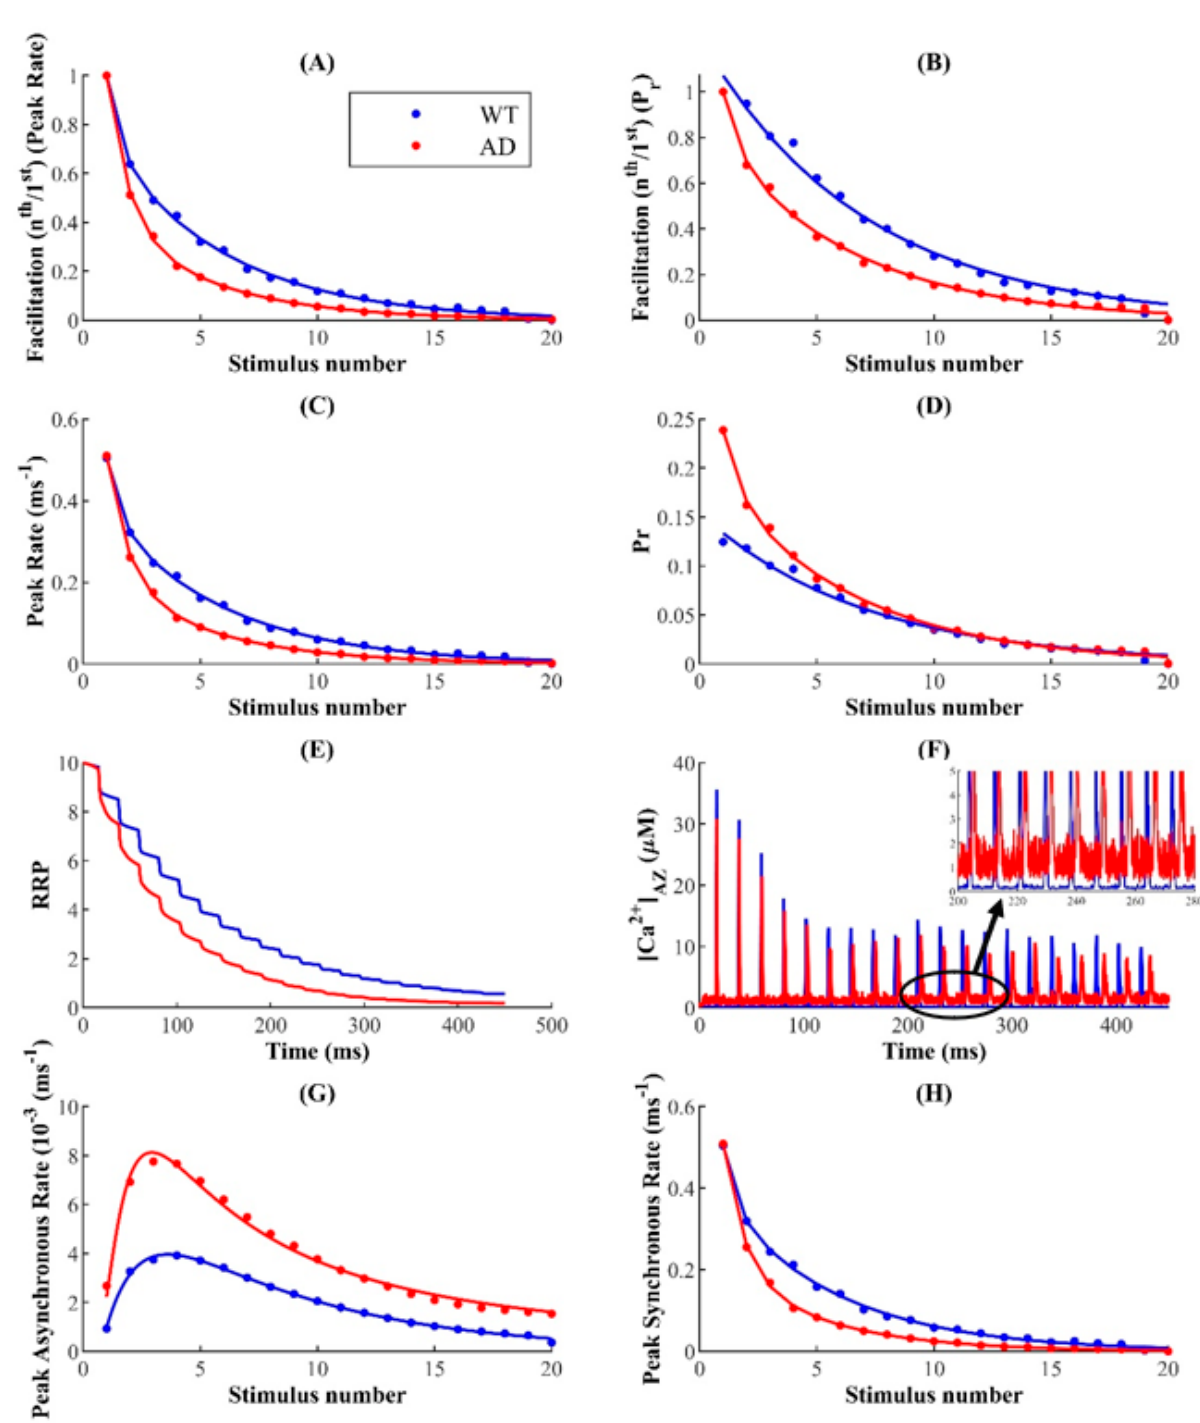
Figure 7. The AD − affected synapse exhibits stronger depression in response to 20 pulse stimulus train delivered at 20 Hz: Facilitation obtained from peak rate ( A ) and P r ( B ) shows that AD pathology induces more severe depression relative to control conditions. Peak release rate ( C ) and P r ( D ) following each AP in the train. ( E ) Pulse train depression is primarily governed by RRP depletion, which is more severe in synapses with AD pathology. ( F ) [ Ca 2 + ] AZ (top) and zoom-in (inset) showing the differences in basal [ Ca 2 + ] AZ levels. ( G ) Asynchronous release peaks and subsequently decays following depletion of RRP. ( H ) Peak synchronous release mimics the response seen in the overall release.